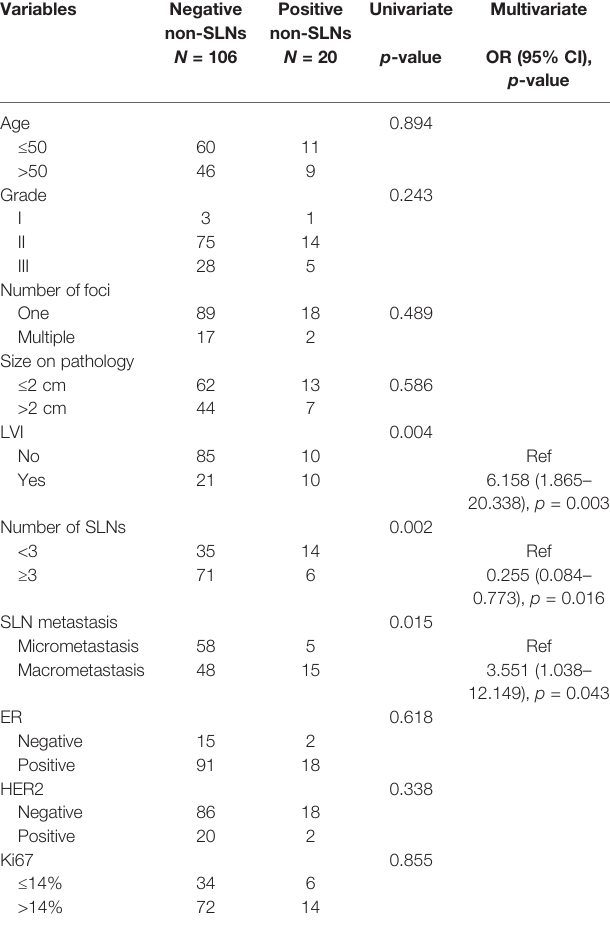
TABLE 2 | Factors associated with positivity of non-SLNs in the ALND group. Variables Negative Positive Univariate non-SLNs non-SLNs